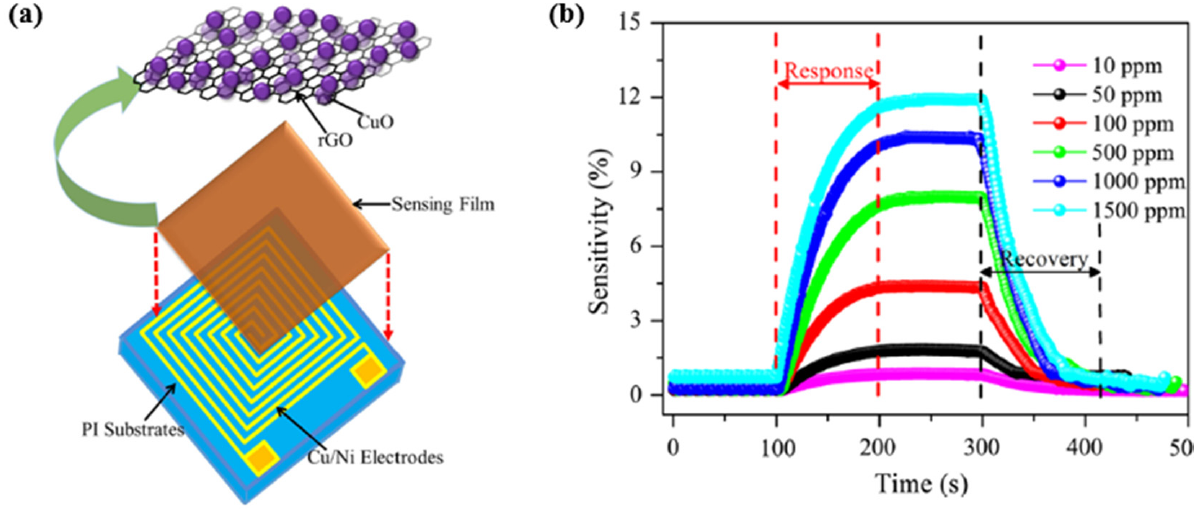
Figure 46. ( a ) Structure illustration of CuO-rGO-CuO hydrogen sensor, and ( b ) response–recovery curves for various concentrations of hydrogen [202]. Copyright (2017), with permission from Springer.